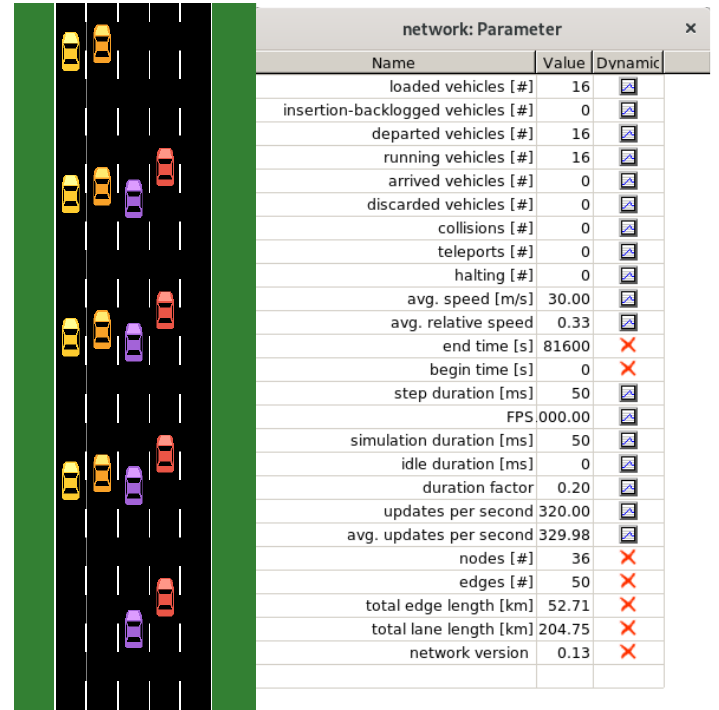
Figure 6. ACC Parameters.